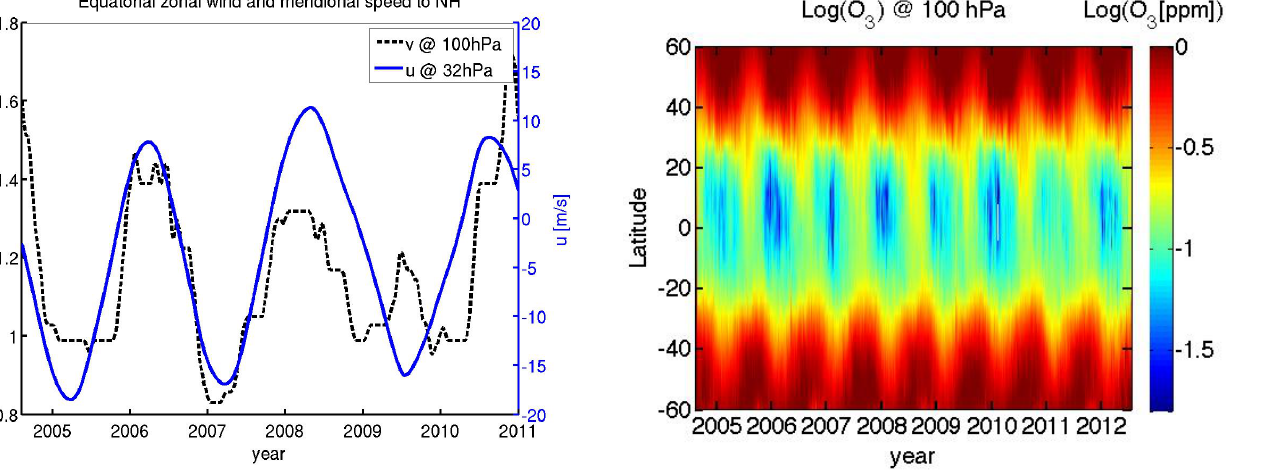
Fig. 12. Logarithm of zonal mean MLS O 3 volume mixing ratios (ppm) at 100 hPa. O 3 rich air from mid-latitudes (red-orange) is mixed into the tropics especially in NH summer and autumn. During winter and spring the low O 3 concentrations (blue) in the tropics are more isolated because mixing equatorwards is strongly reduced.